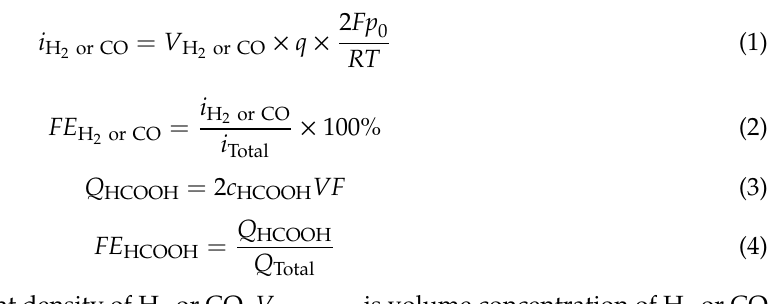
Figure S1: The SEM image of Cu foam. Figure S2: The cross-sectional views of Cu / SnO 2 . Figure S3: SEM elemental mapping for ( a ) Cu / SnO 2 and ( b ) A-Cu / SnO 2 before pre-reduction. The table is EDX analysis identifying. Figure S4: XRD patterns of Cu Foil and Cu foam. Figure S5: XPS survey spectra of Cu / SnO 2 , A-Cu / SnO 2 before and after pre-reduction. Table S1: The content of Cu and Sn of Cu / SnO 2 and A-Cu / SnO 2 obtained from ICP-AES. Table S2: Summary of atomic percent of Cu / SnO 2 and A-Cu / SnO 2 before and after pre-reduction obtained from XPS and SEM-EDX elemental mapping. Table S3: The current density at di ff erent potentials obtained from Figure S13 on ( a ) Cu foam, ( b ) Cu / SnO 2 , ( c ) A-Cu / SnO 2 and ( d ) Sn plate. Table S4: Mass fraction and atomic fraction of Cu, Sn, O on the surface of the electrode with di ff erent deposition time of SnO 2 detected by